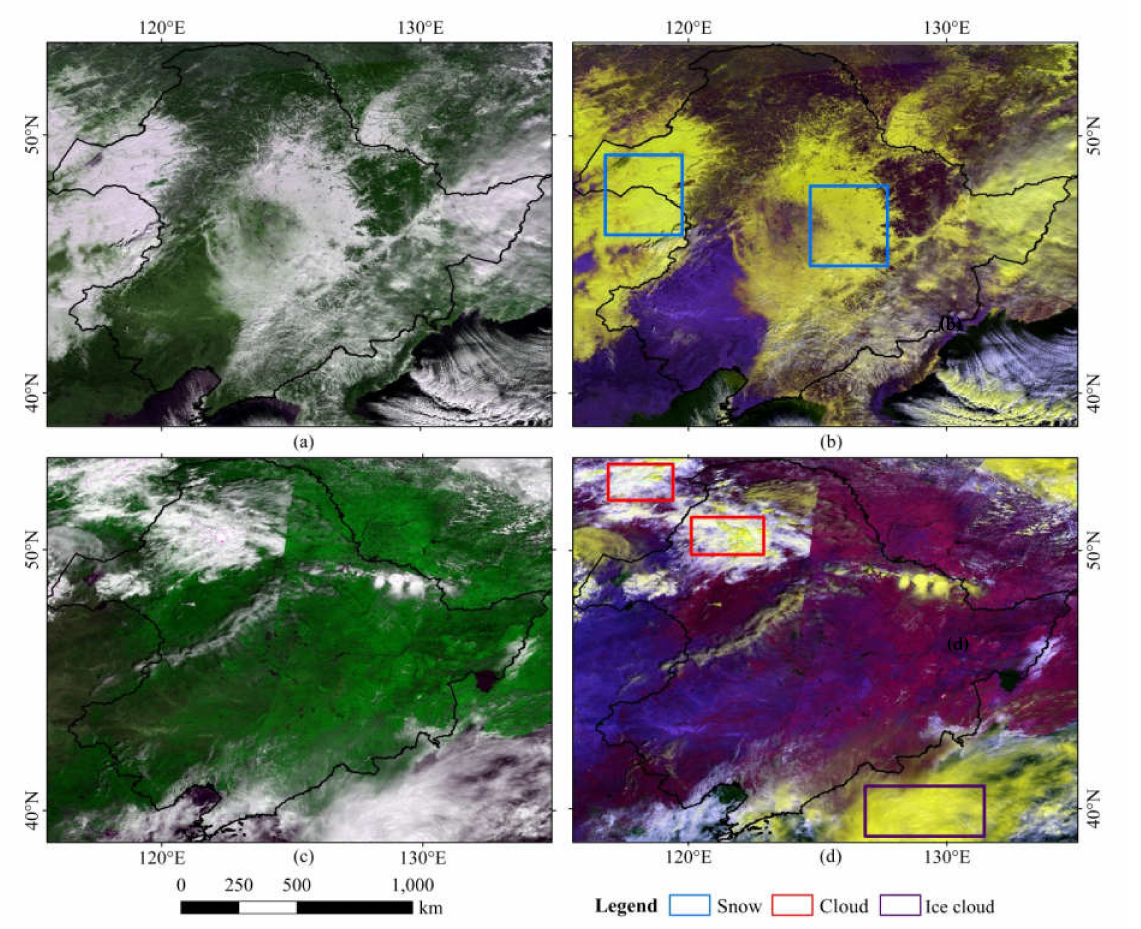
Figure 5. False-color image of the study area ( a ) acquired on 10 January, 2018, combined with bands 1/2/4, ( b ) acquired on 10 January, 2018, combined with bands 2/4/6, ( c ) acquired on 1 July, 2018, combined with bands 1/2/4, ( d ) acquired on 1 July, 2018, combined with bands 2/4/6.